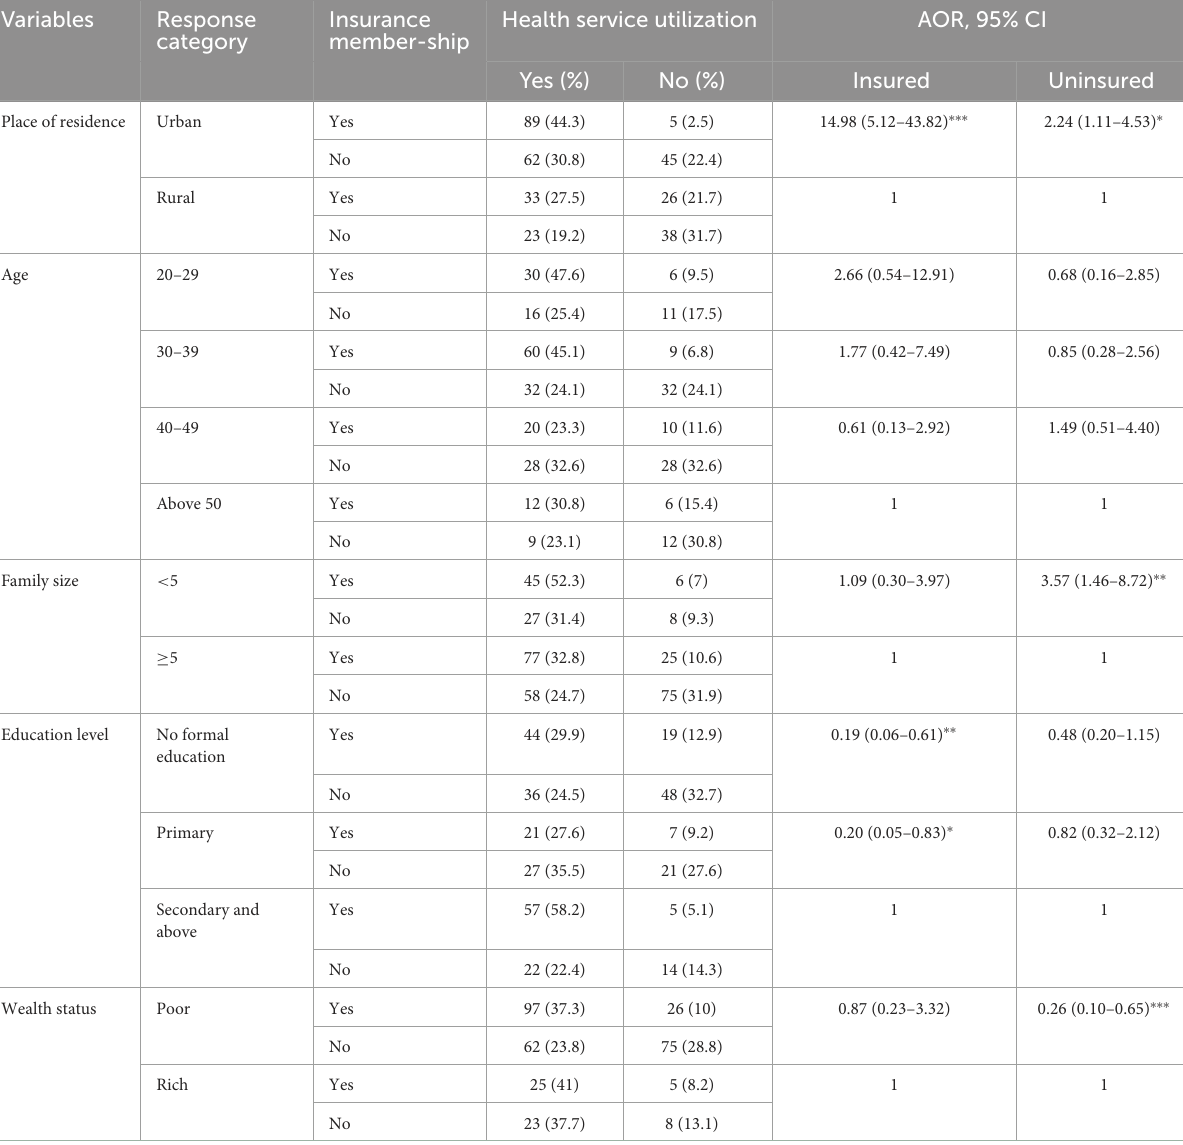
TABLE 4 The effects of the CBHI scheme on the disparity in health service utilization among households in the Gida Ayana district, Oromia Regional State, Ethiopia, 2022.